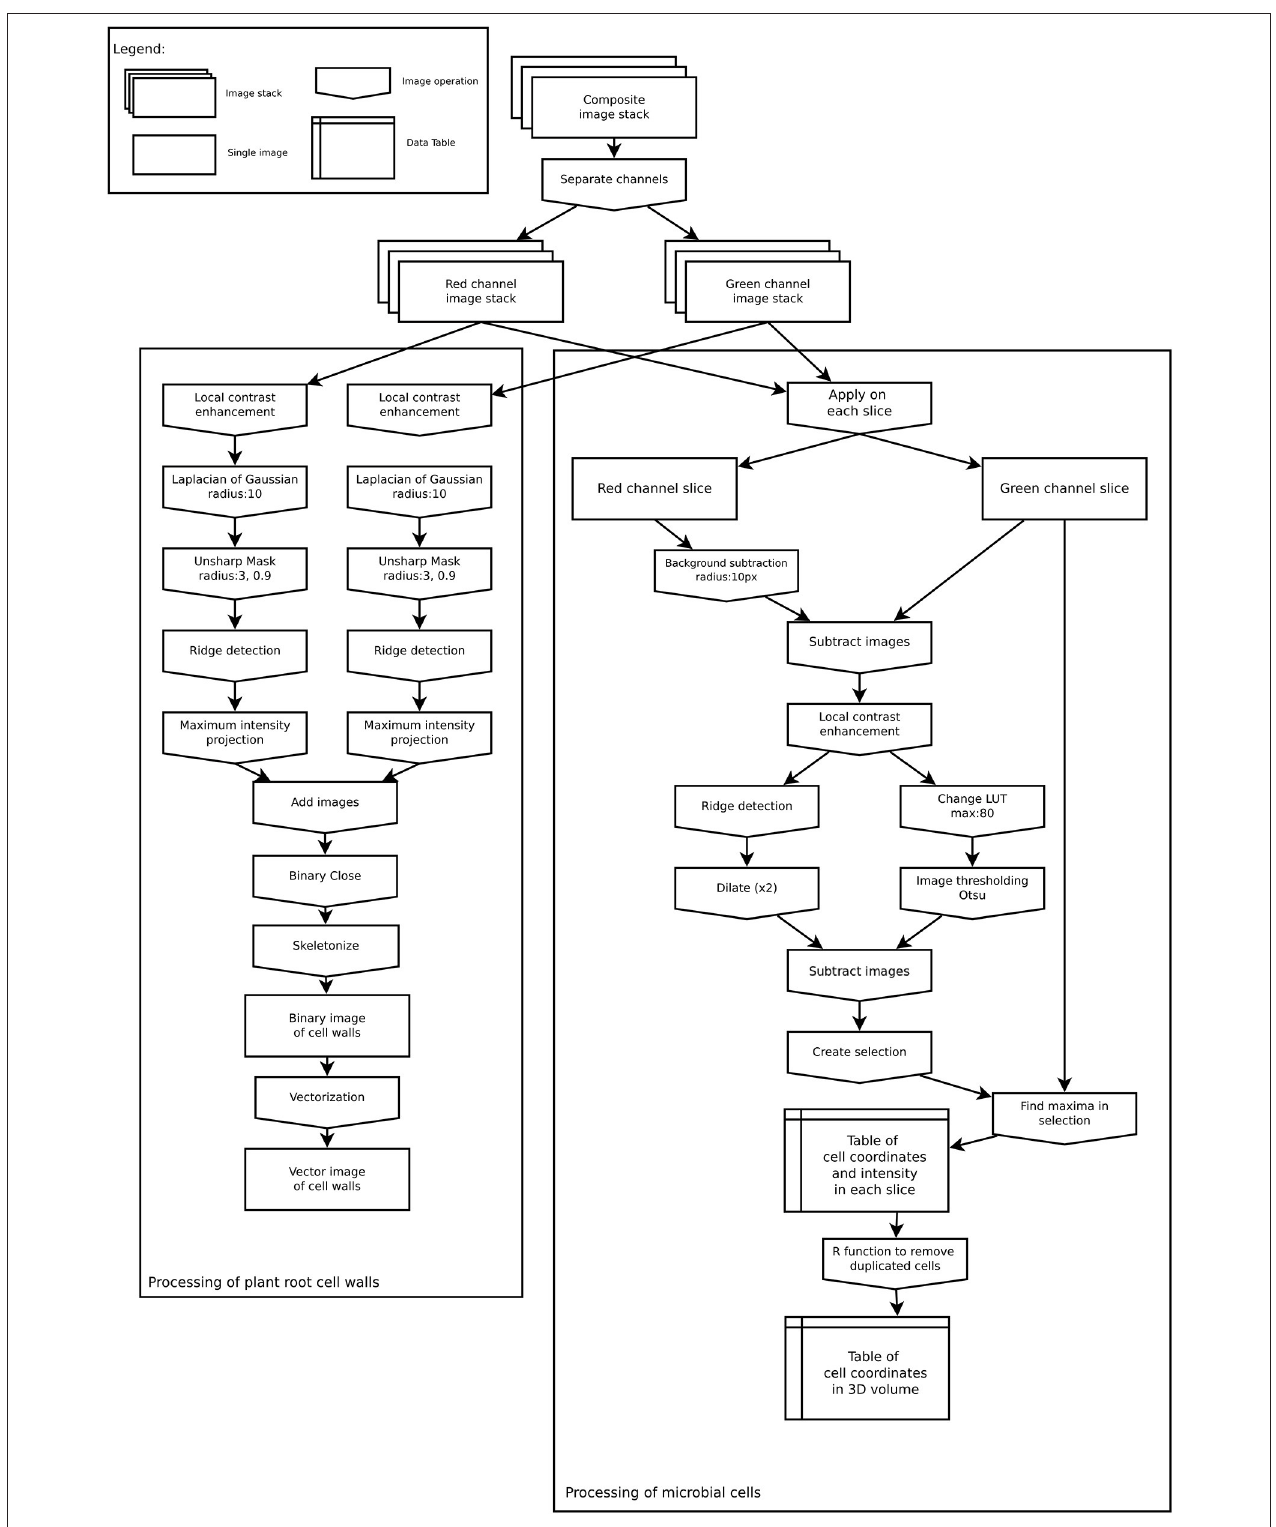
FIGURE 2 | Image analysis workflow to extract root cell walls (Left) and microbial coordinates (Right) .